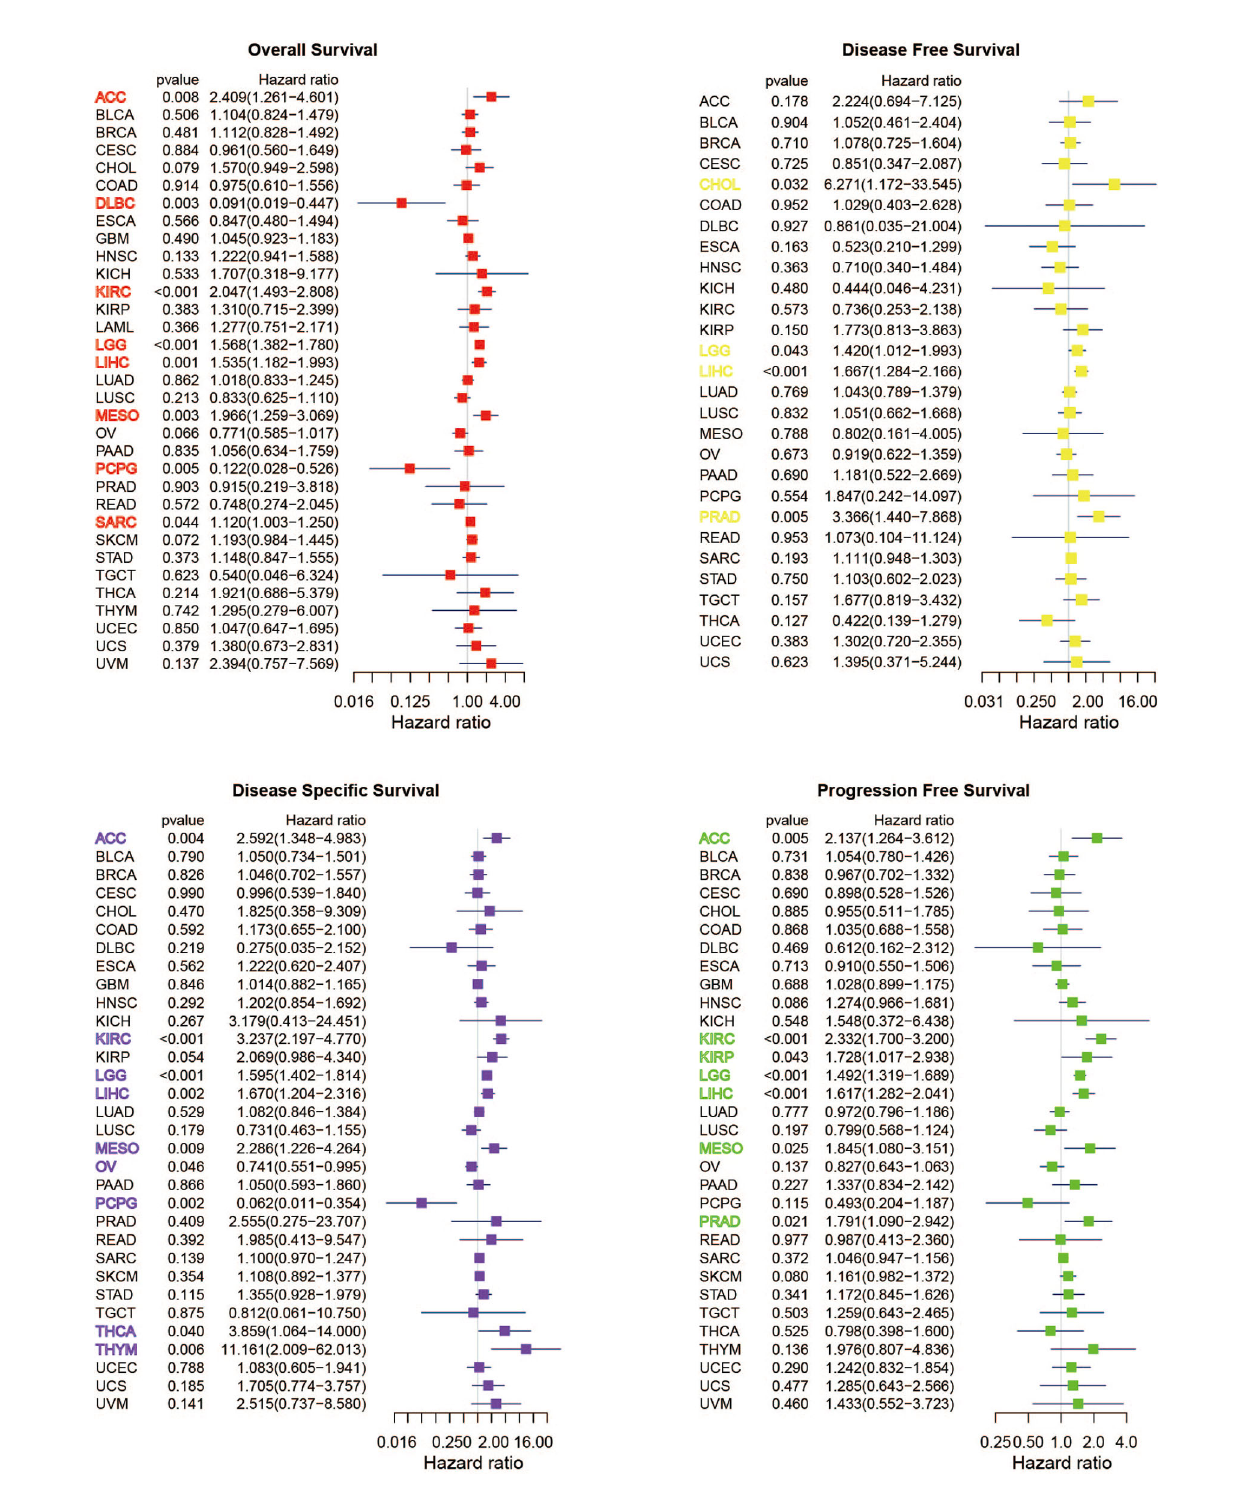
FIGURE 4 | Univariate Cox regression analyses for METTL1 expression in pan-cancer. Forest plot visualizing the association of METTL1 expression and OS, DFS, DSS as well as PFS respectively among pan-cancer. Hazard ratio (HR) value > 1 represents risk factor, whereas HR value < 1 represents favorable factor.